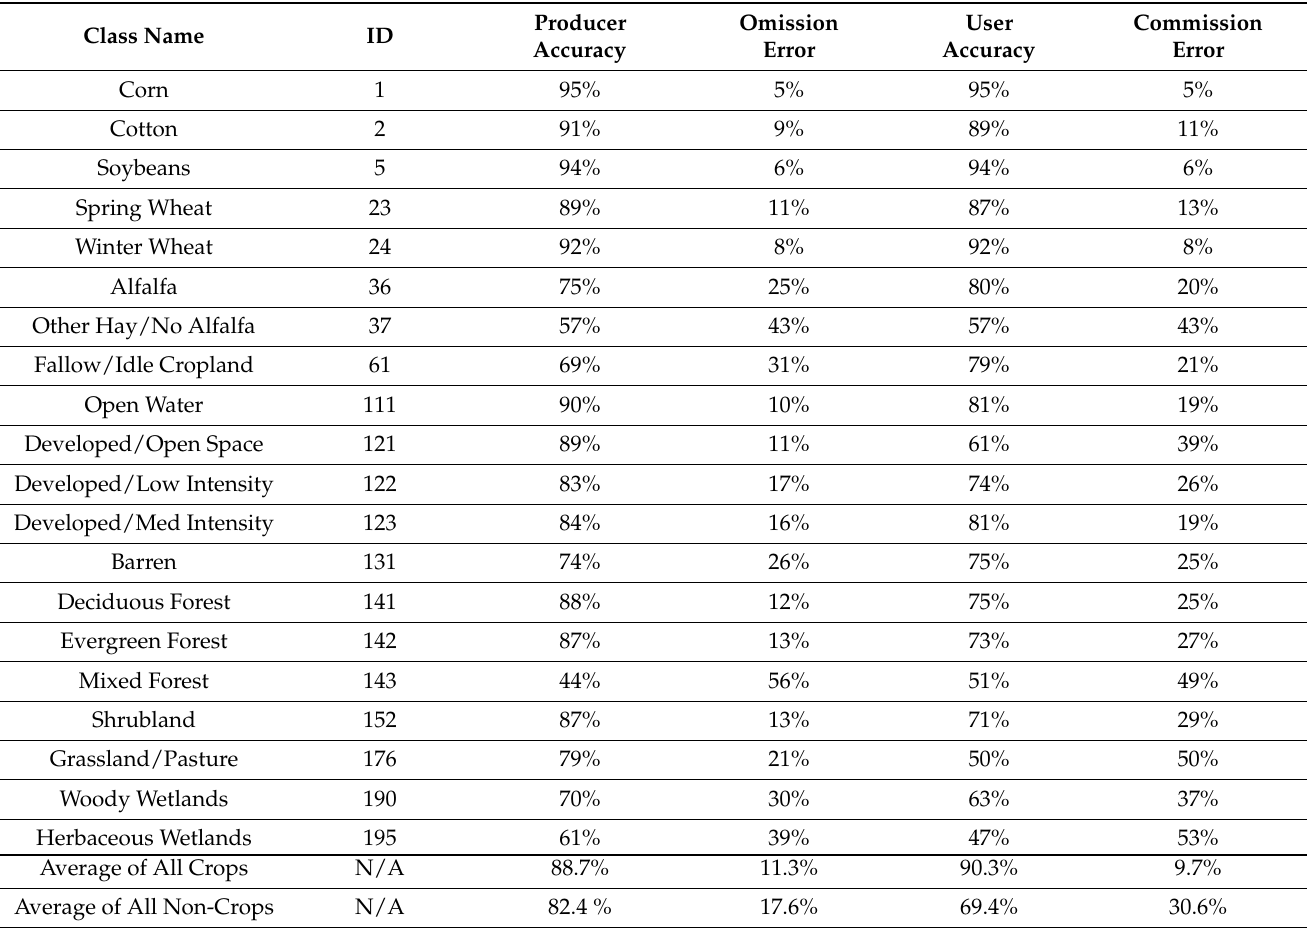
minor crops. To this end, the 10 crops with the highest producer’s accuracies made up 71.5% of the total mapped crop area. Table 2. Nationwide class accuracies of major individual land covers in the 2012 Cropland Data Layer (CDL). Table shows area-weighted national average accuracies for the 20 most common classes by area in the 2012 CDL, calculated according to Equation (6), based on data from USDA National Agricultural Statistics Service (NASS). National accuracies of all crops and land covers for 2012 are listed in Appendix A Table